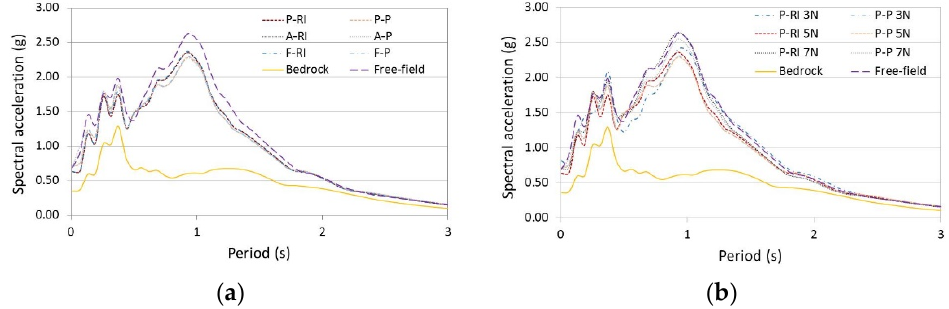
Figure 9. Acceleration response spectrum of the 5-storey building with different support conditions. ( a ) 5-storey Building; ( b ) 3-, 5- and 7-storey Buildings. ( a ) 5-storey Building; ( b ) 3-, 5- and 7-storey